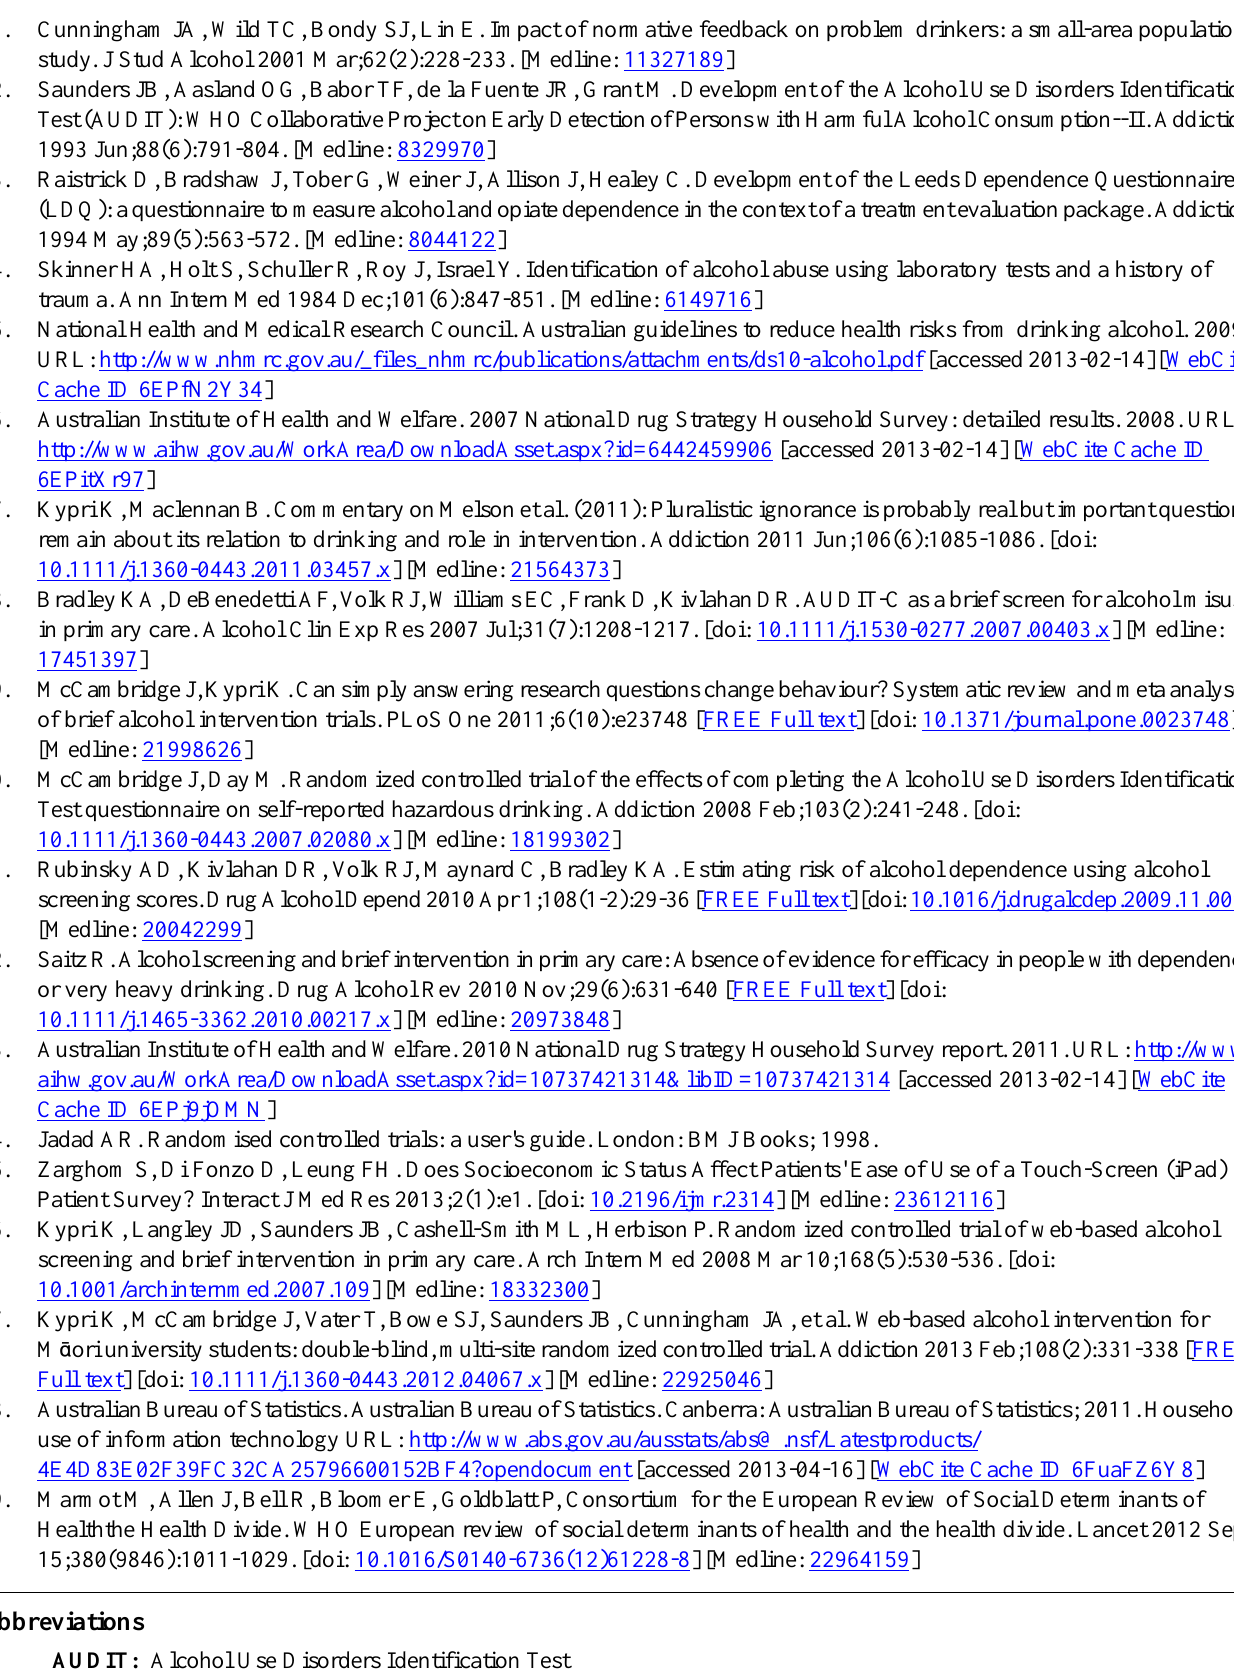
AUDIT-C: Alcohol Use Disorders Identification Test Consumption subscale BAC: blood alcohol concentration e-SBI: electronic alcohol screening and brief